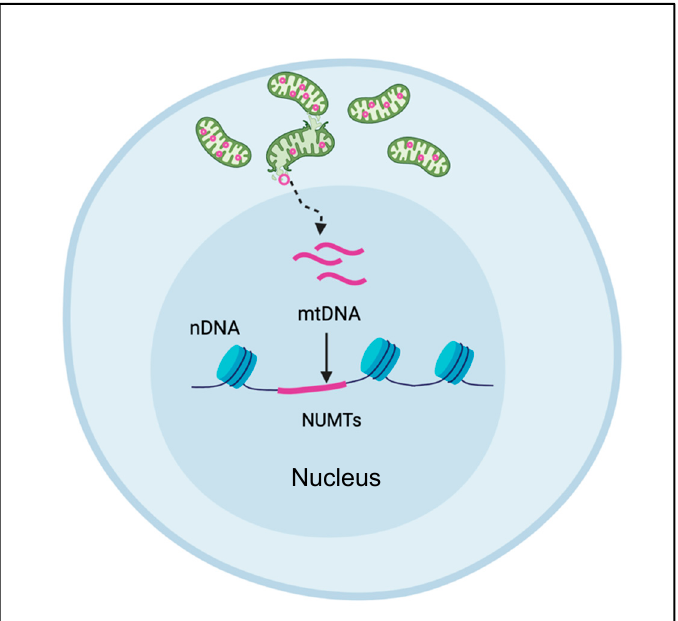
Figure 3. NUMT formation. Nuclear encoded mitochondrial sequences (NUMT) arise when mtDNA sequences are released from the mitochondrion and enter the nucleus to become incorporated into the nuclear DNA.